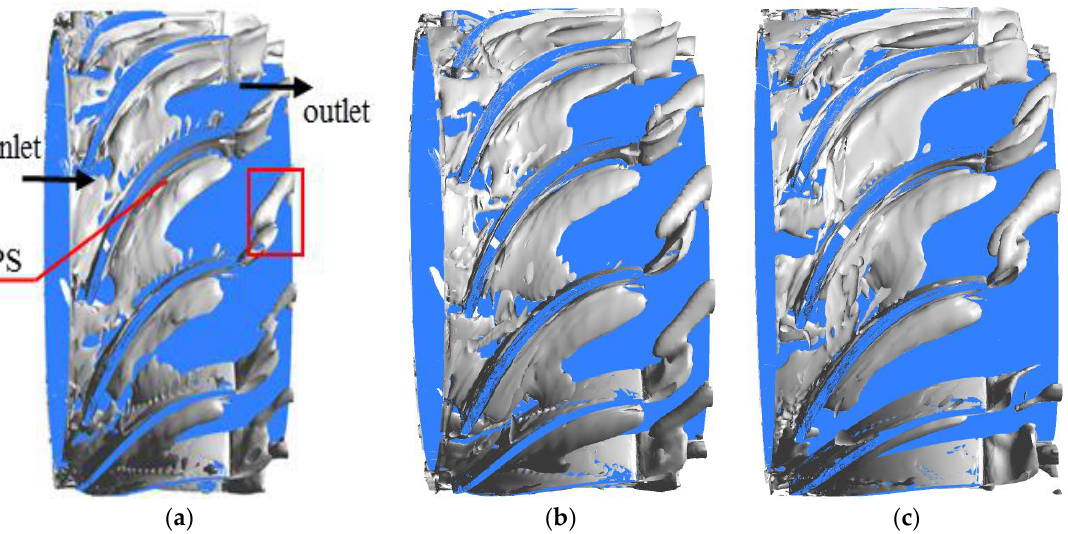
Figure 13. Structure of gas vortexes in the guide vane at different IGVF s (Q = 2 × 10 5 ). ( a ) IGVF = 9%; ( b ) IGVF = 15%; ( c ) IGVF = 21%.